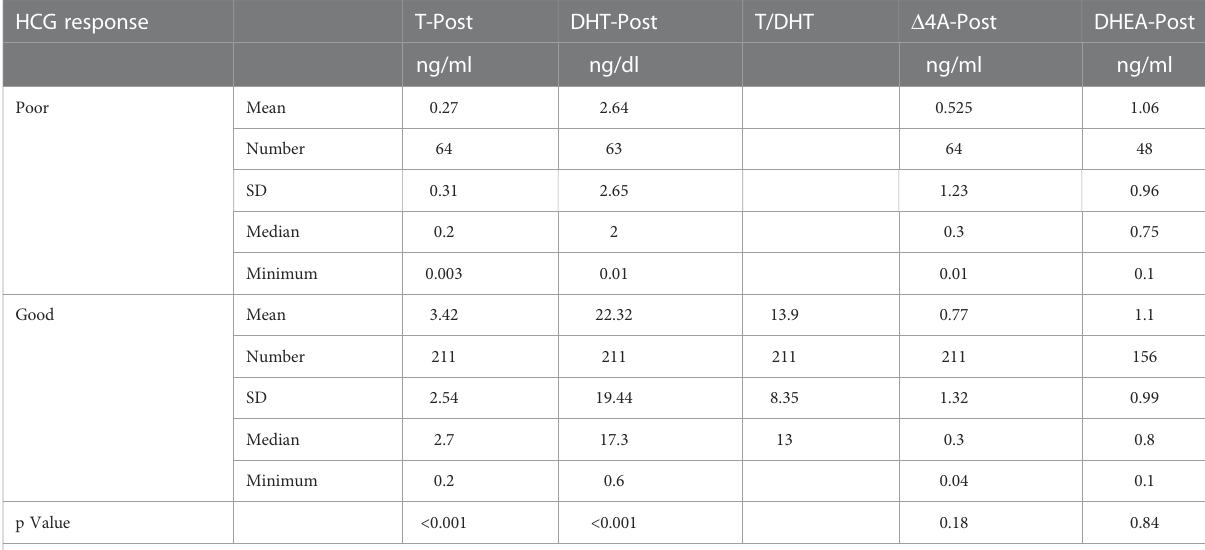
TABLE 3 Comparison between patients with suf fi cient and inadequate HCG response regarding post stimulation hormonal levels.